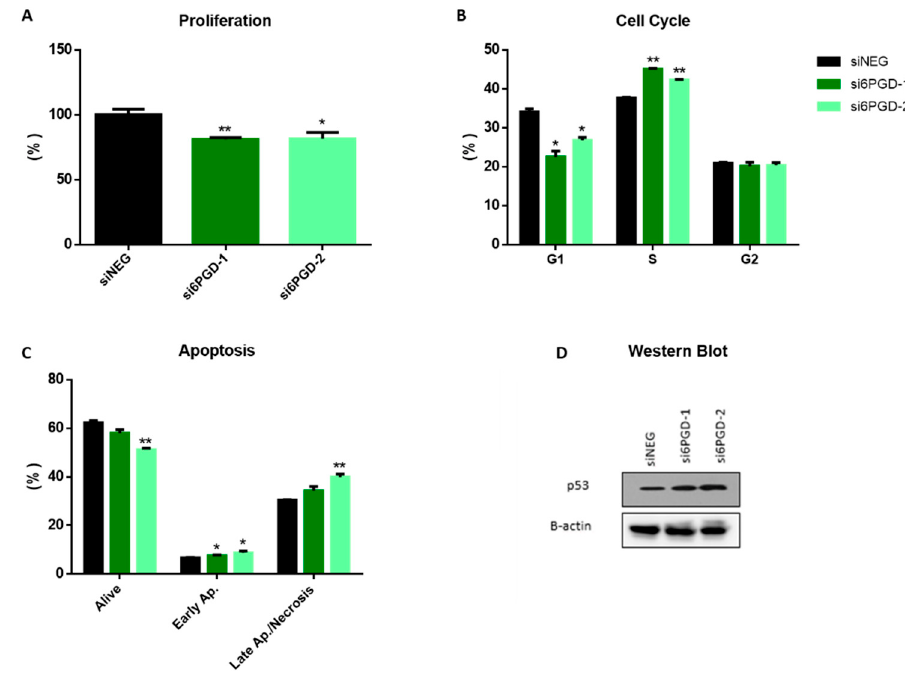
Figure 2. ( A ) Flow cytometry measurements of cell proliferation, 96 h after transfection, for 6PGD- knockdown cells and cells transfected with siNEG. ( B ) Cell cycle distribution analysis of MCF-7 cells after 96 h of siRNA transfection. The percentage of cells in the different cell cycle phases was calculated using FlowJo ® software. ( C ) Apoptosis analysis of MCF7 cells after 96 h of siRNA transfection, measured by flow cytometry using annexin V FITC kit, 96 h after transfection. The percentage of cells in the different apoptosis phases was calculated using FlowJo ® software. ( D ) Western blot analysis of p53 expression in cells transfected with si6PGD vs. cells transfected with siNEG 96 h after transfection. One asterisk (*) denotes p -value < 0.05, two asterisks (**) denote p -value < 0.01.